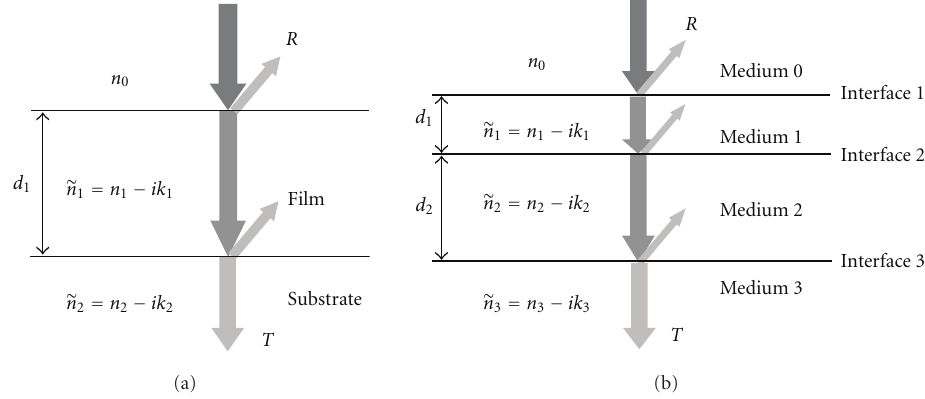
Figure 1: Schematic geometry for: (a) the 3M structure with a semiinfinite substrate and (b) the 4M structure with a single film (medium 1) on a substrate of finite thickness d 2 (medium 2); media 0 and 3 correspond to the input and output